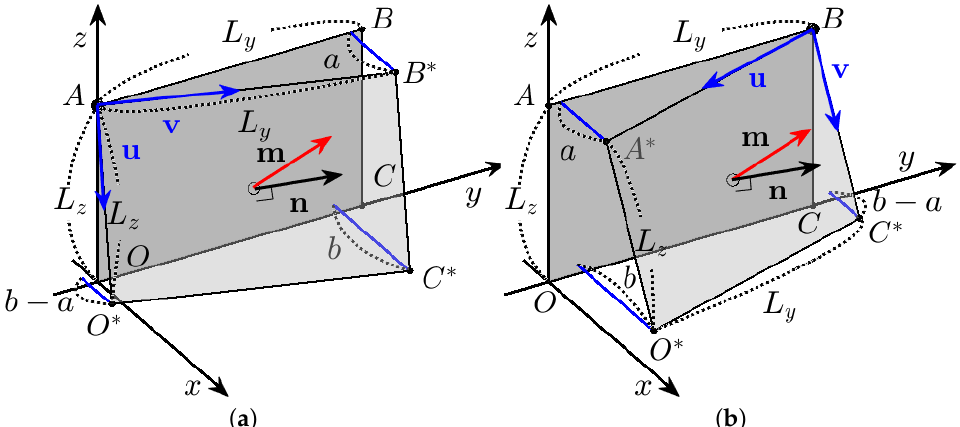
Figure 2. Schematic illustrations of our mathematical modeling to the rotated panel, ( a ) fixing A and ( b ) fixing B